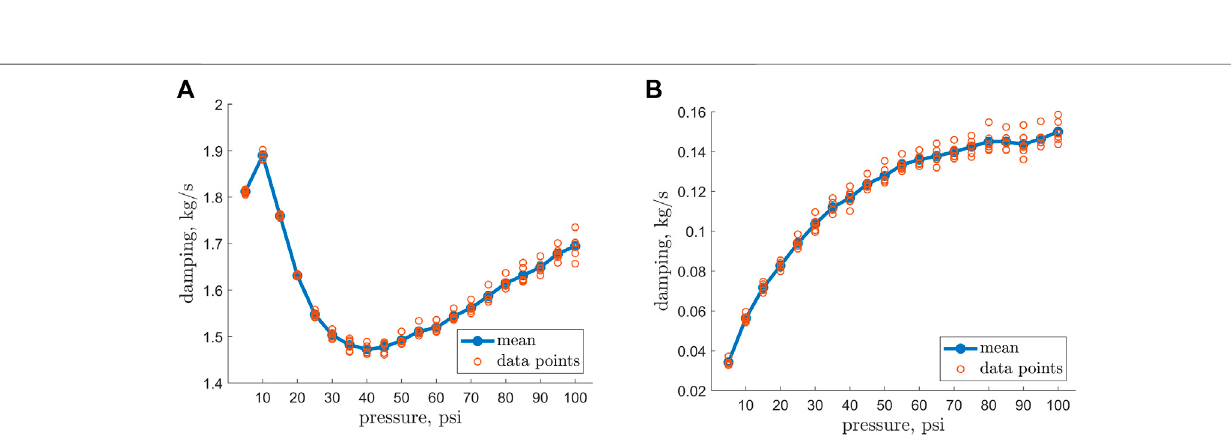
Frontiers in Robotics and AI |